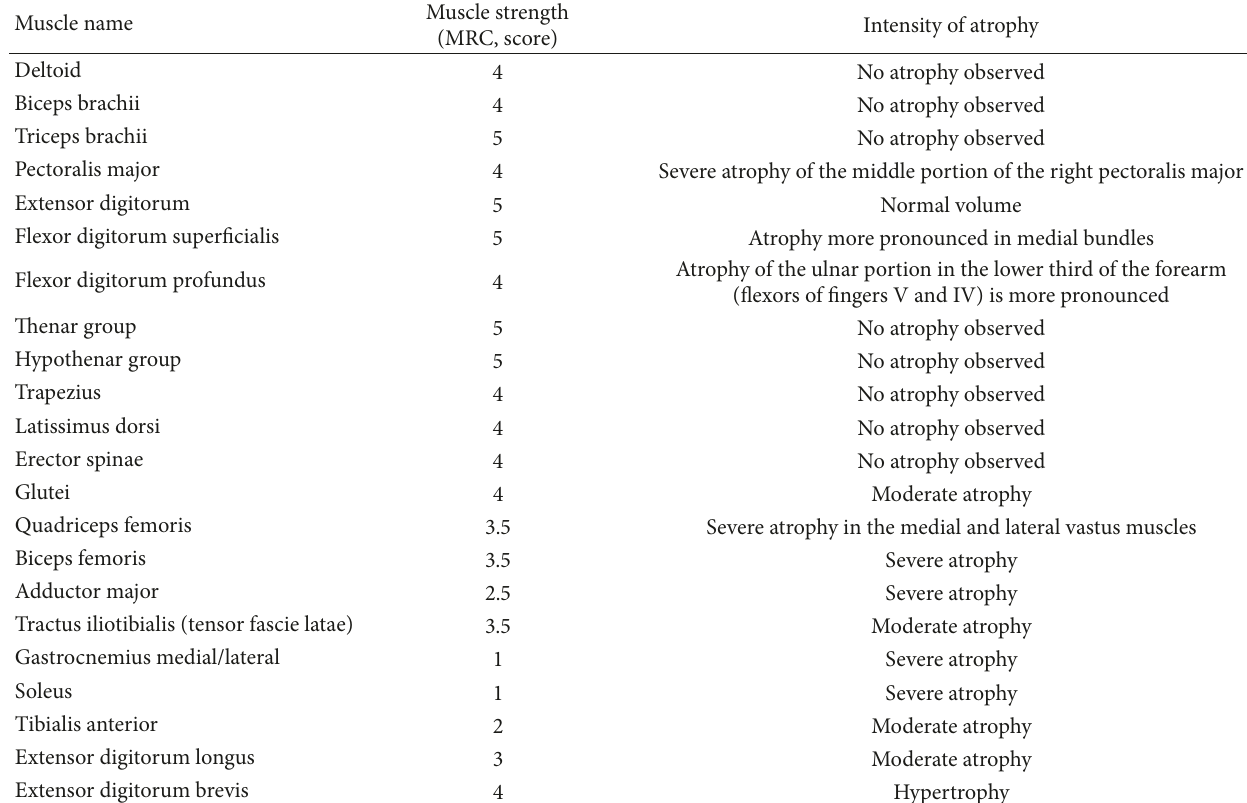
Table 1: Clinical characteristics of Proband (III:4) skeletal